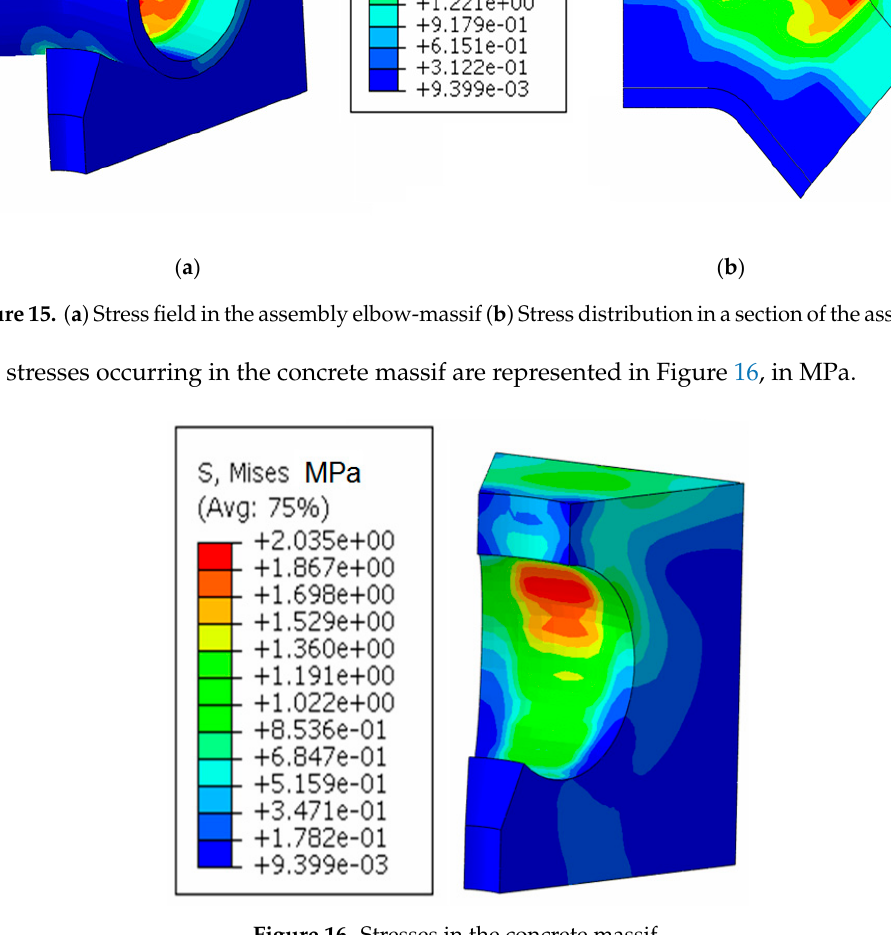
( b ) Figure 17. ( a ) Contact pressures on the surface of the massif; ( b ) Polyethylene elbow stresses. The stresses that develop in the elbow are shown in Figure 17b, in MPa. The maximum stress in the elbow is 3.643 MPa << 21.9 MPa, which is the allowable stress of PE 100 type materials. The elbow is well dimensioned and, if properly mounted, it will not be destroyed due to the loads applied to the material in normal use. Plastic deformation in the elbow is max 0.228% << 840% (breaking elongation of PE 100 type materials). Existing requests for material are not likely to destroy it [36-38]. If the elbow fabrication and assembly have been correctly executed and there are no inclusions, micro-cracks or other defects, the use in normal parameters does not destroy the integrity of the elbow material. 4.3. Comparative analysis of the Results Obtained with the MEF in the Case of Elbow DN 315, Buried in the Ground and Anchored in Concrete